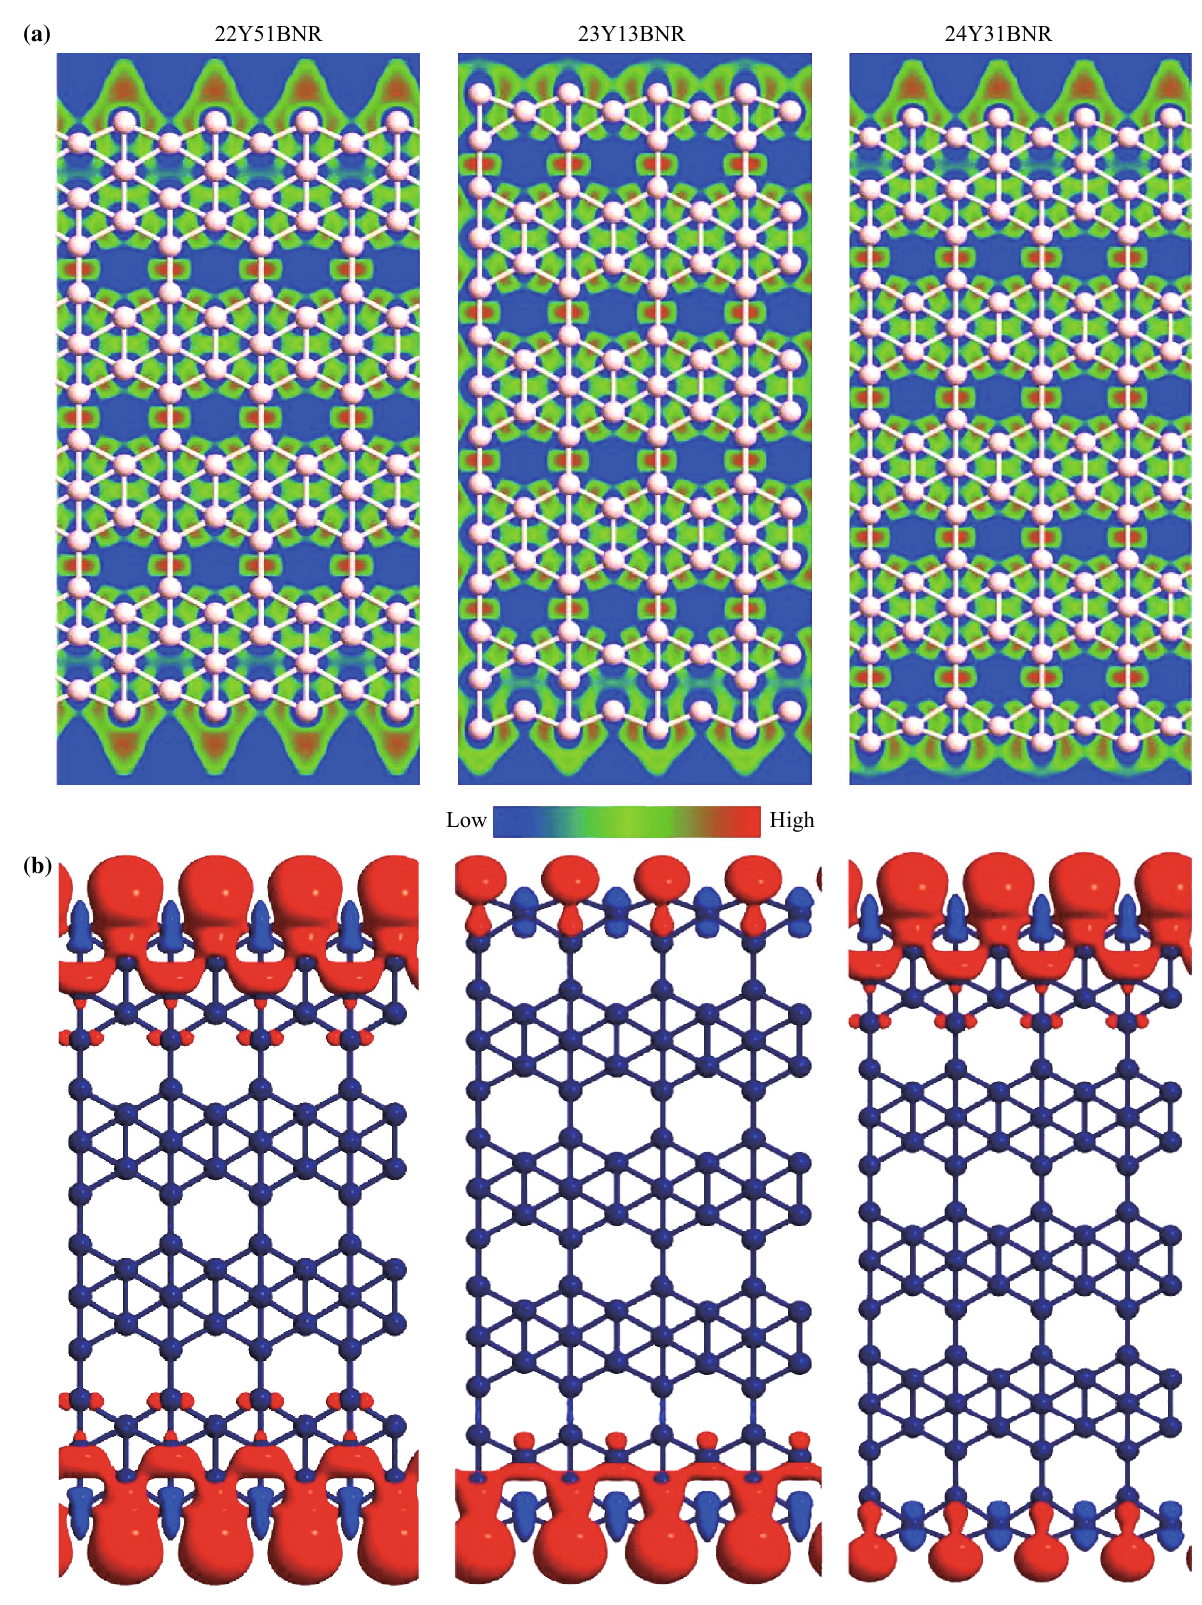
Fig. 9 a The electron localization function and b the spin density of 22Y51 , 23Y13 , and 24Y31 . The isovalue is